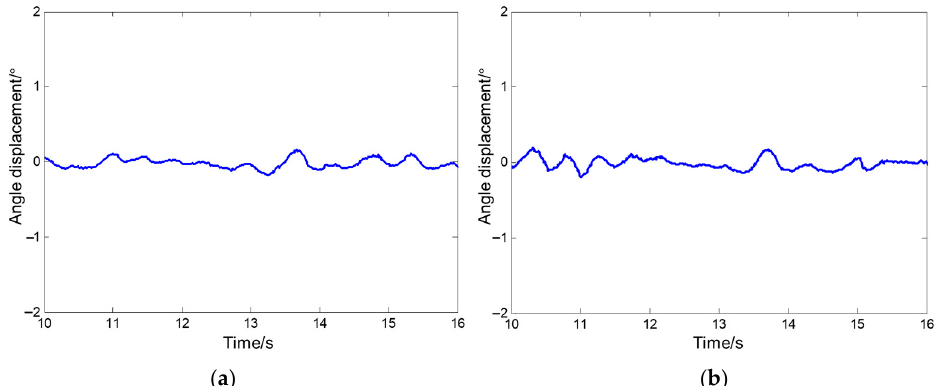
Figure 13. X-and- Y -axis attitude stability test results of the platform. ( a ) Angular displacement in X axis, ( b ) Angular displacement in Y axis.